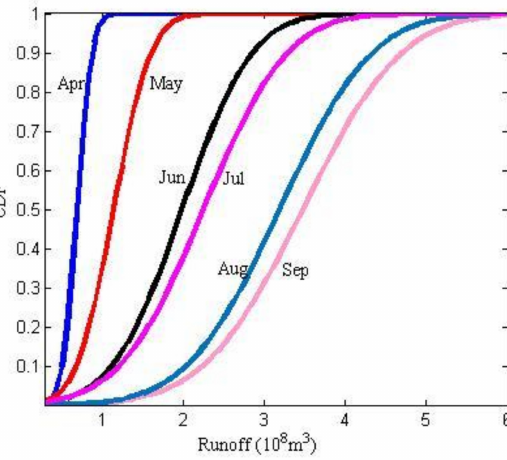
Figure 2. Cumulative probability distribution (CDF) for monthly runoff from Yingluoxia hydrometric